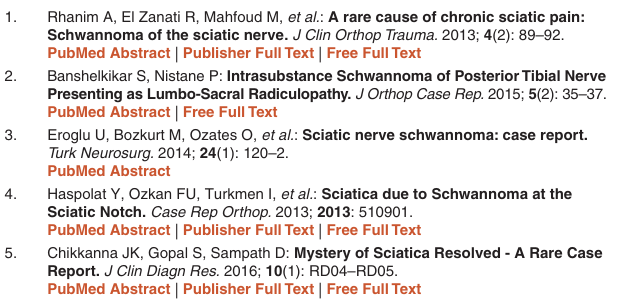
spine 1 . Other differential diagnoses included sciatic nerve tumors, a far lateral disc or Pyriformis syndrome. The main imaging modality for the diagnosis of sciatic nerve schwannoma was MRI imaging of the affected sciatic nerve.